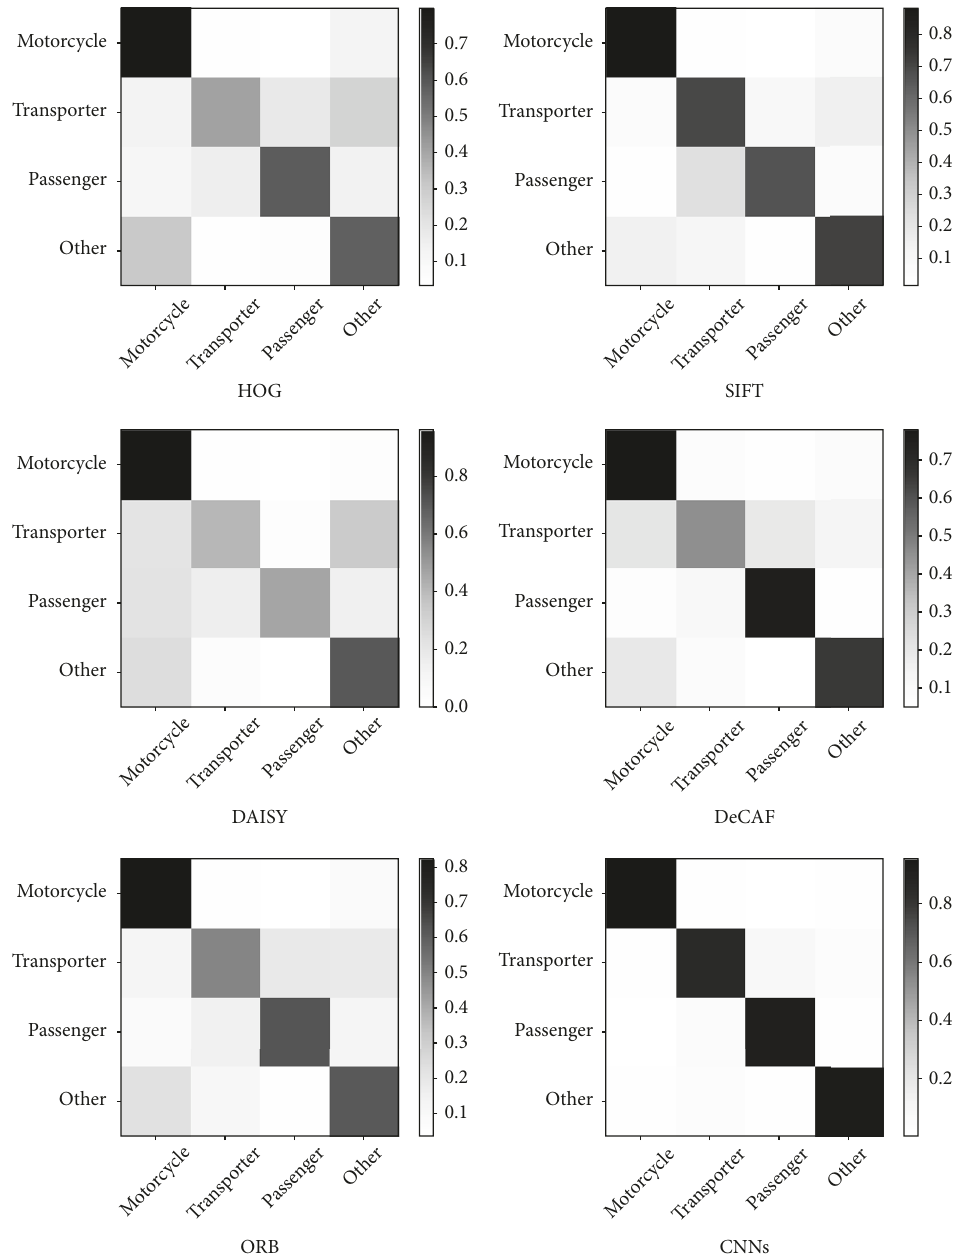
Figure 6: Confusion matrix of classification of different